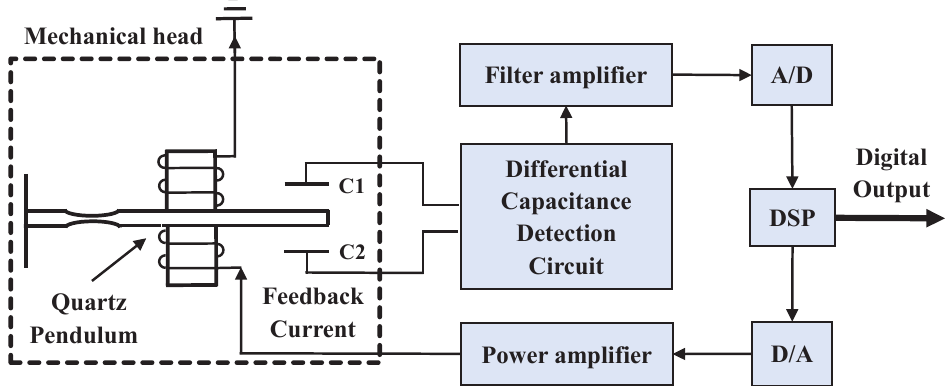
Figure 1. Structure of digital quartz flexible